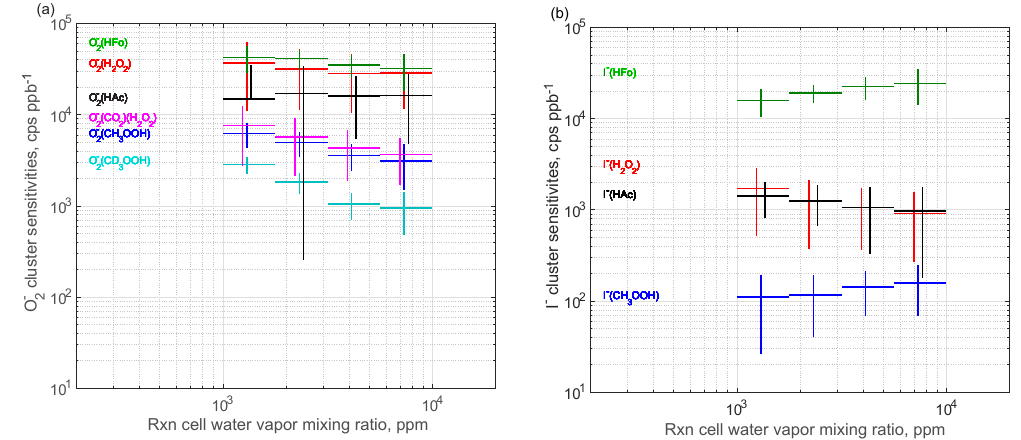
Figure 4. FRAPPÉ in-flight sensitivities (cpsppb − 1 ) as a function of reaction cell water vapor for all PCIMS clusters. The left panel contains all the O − cluster and the right panel contains all the I − clusters. The horizontal and vertical error bars represent the same information as in 2 ( CD 3 OOH ) refers to the deuterated MHP Fig. 3. O − 2